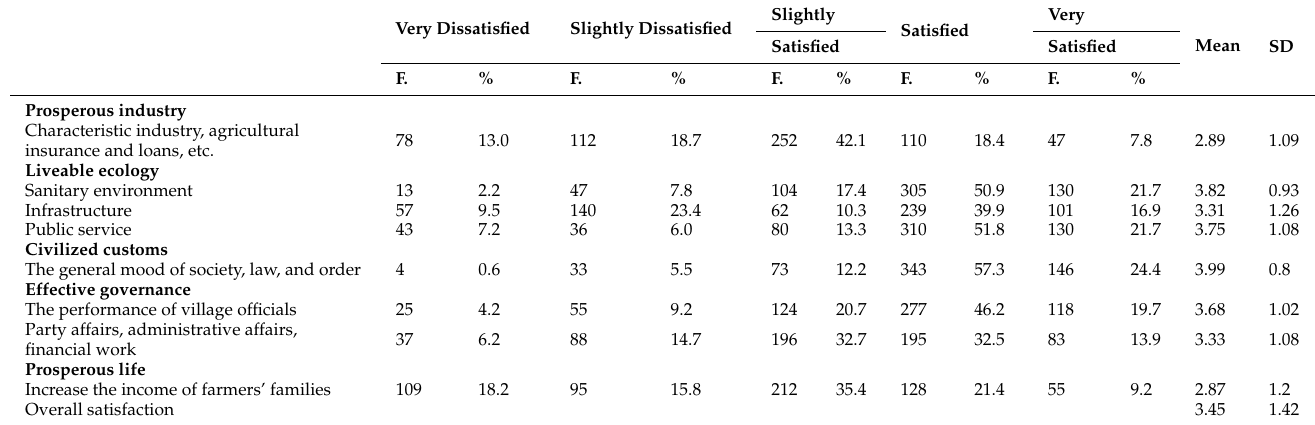
Table 4. Distribution of respondents according to their satisfaction with SRD